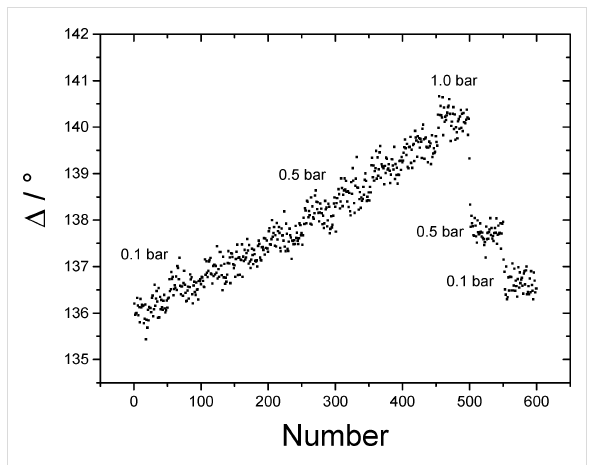
Figure 3: Δ signal depending on different air pressure values at an AOI of 47.9°. The pressure was changed every 50 measurement points by 0.1 bar up to a pressure of 1.0 bar. Then the pressure was reduced to 0.5 and 0.1